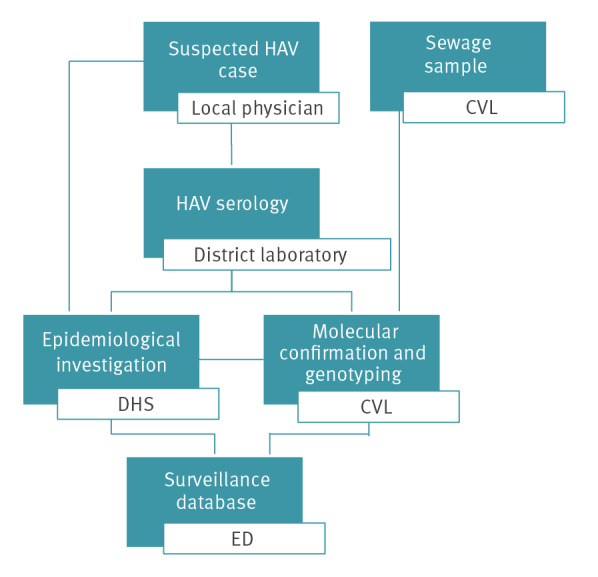
Proposed model for hepatitis A virus surveillance in countries with childhood vaccination programmes